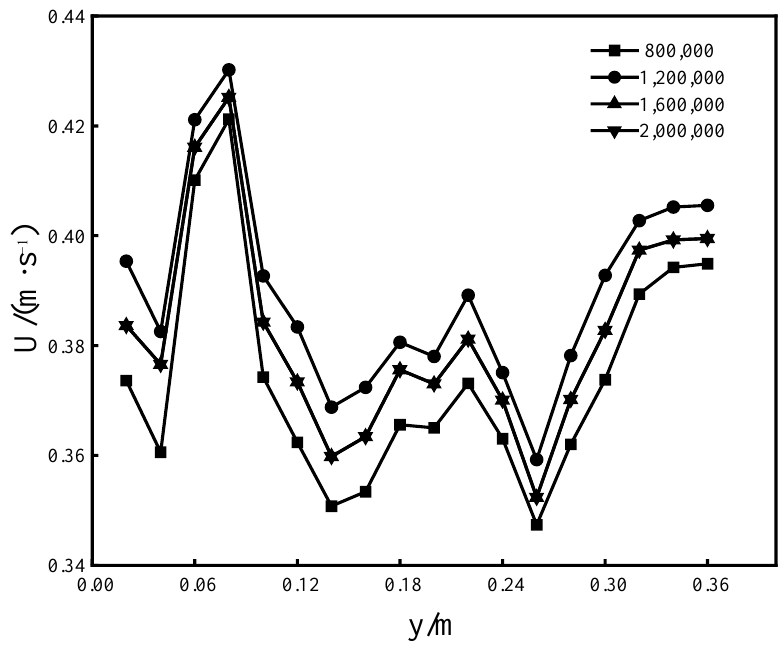
Figure 4. Total velocity distribution.